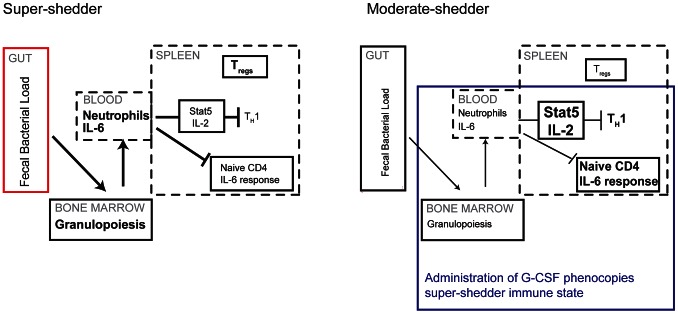
Neutrophils control the dampened systemic TH1 response of super-shedders.In super-shedders, high levels of Salmonella in the gastrointestinal tract induce systemic neutrophilia with extensive granulopoiesis occurring in the bone marrow, resulting in elevated neutrophil counts in the blood, GI tract and spleen. This is accompanied by dampened IL-2 and IL-6 cytokine responsiveness in splenic CD4 T cells, fewer TH1 cells and more Tregs. In moderate shedders, low levels of gastrointestinal Salmonella induce very few neutrophils systemically, leading to an active IL-2 and IL-6 response with increased TH1 cells and fewer Tregs. Induction of granulopoiesis in moderate-shedders results in the super-shedder immune phenotype with the exception of Tregs, which remain unchanged.